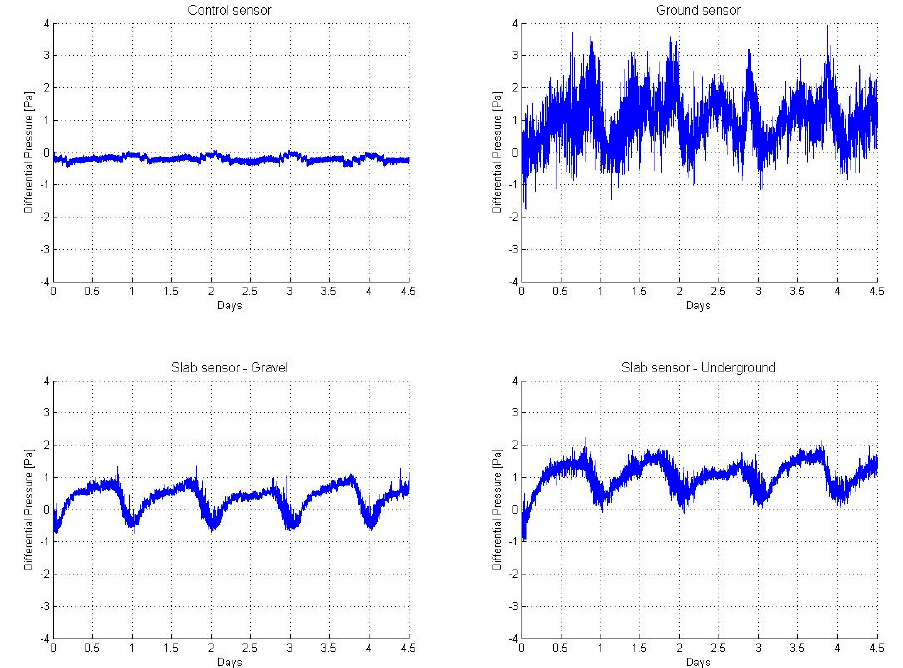
Figure 17. Behavior of natural di ff erential pressure between atmosphere and soil over time.